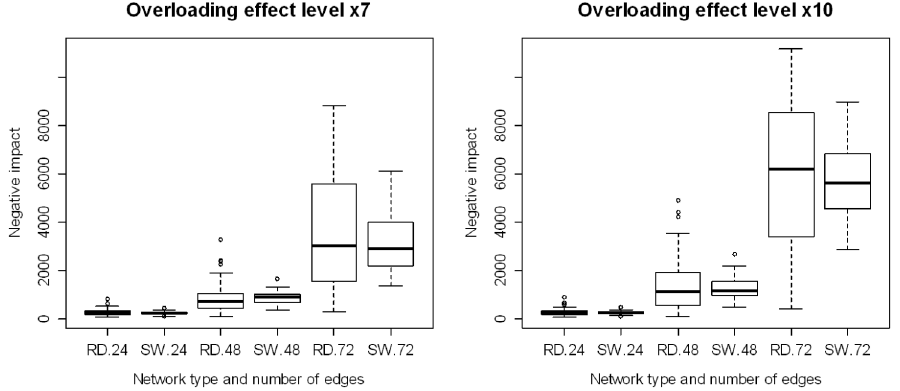
Figure 6. Network connectivity increases the average negative impact of the network (i.e. number of malfunctions) – this increase is higher with